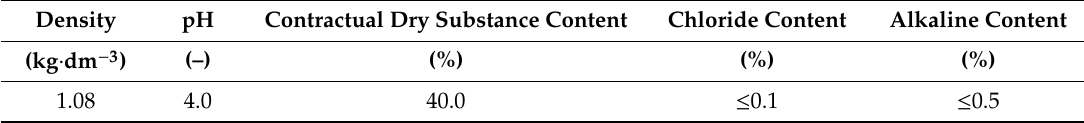
Table 5. Properties of polycarboxylate superplasticizer.